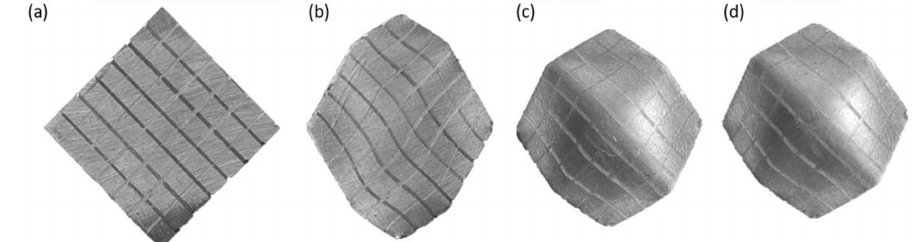
Figure 6. Cross-section and mesh cells ( a ) initial specimen, ( b ) after the second stage, ( c ) after the eighth stage, ( d ) after the twelfth stage.